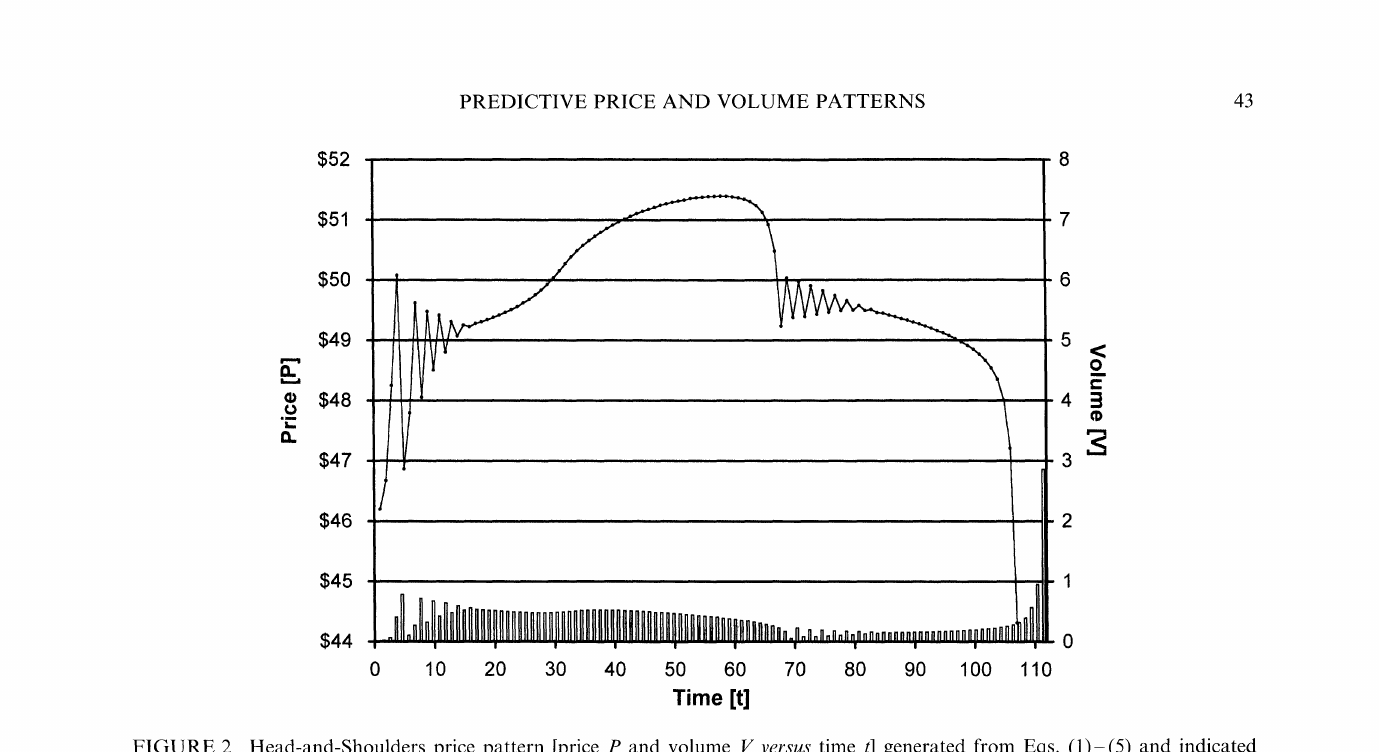
FIGURE 2 Head-and-Shoulders price pattern [price P and volume V versus time t] generated from Eqs. (1)-(5) and indicated initial parameters in Table